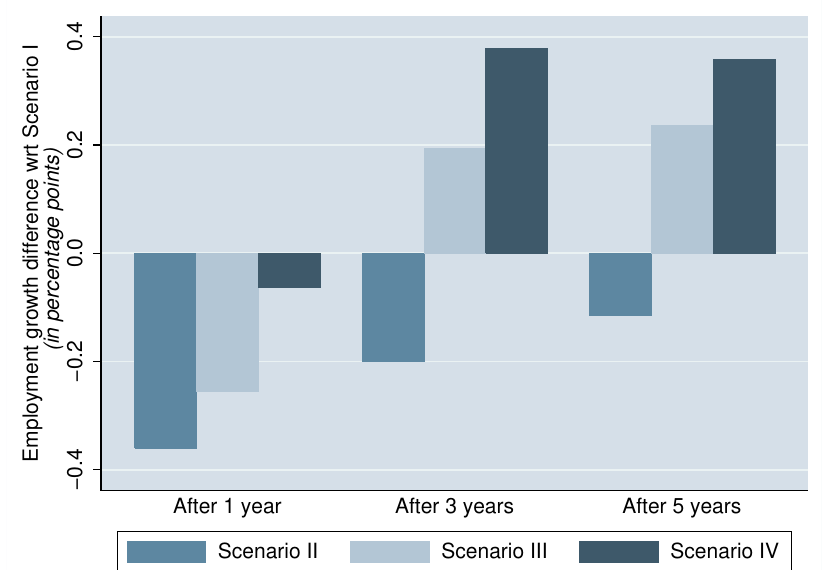
Figure 6. Comparisons of employment dynamics: Scenarios II–IV vs. Scenario I. Note: The chart compares employment growth rates of different reform scenarios with the baseline. The bars represent differences in annual employment growth rates in percentage